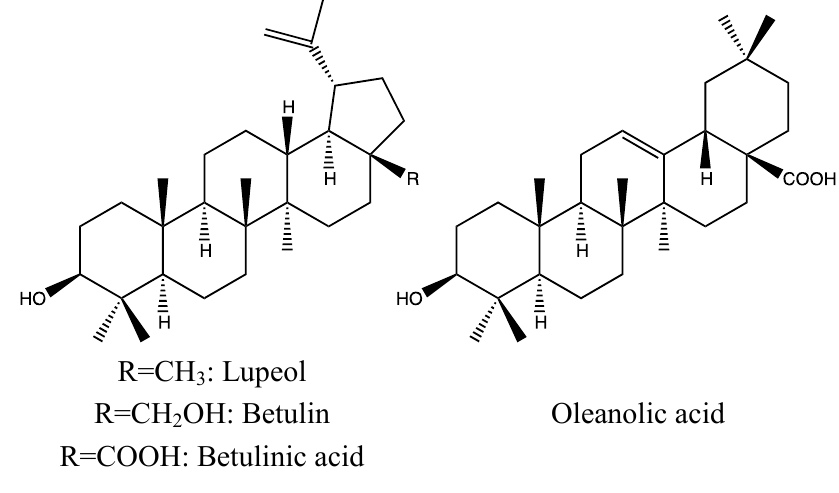
Figure 2. Triterpenoids from Diospyros peregrina bark and seeds. In the formulas in this paper, selected substances from the active plant parts are shown. Ubiquitous substances have been omitted. In most cases, it is unknown which substances are responsible for the anti-diarrhoea